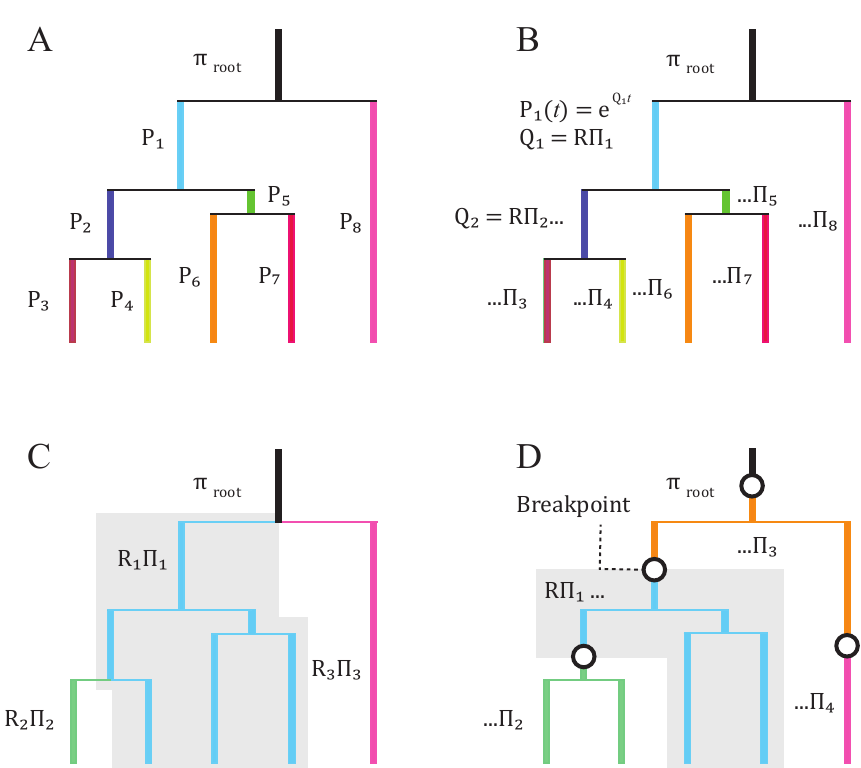
Figure 1. Illustration of the variety of nonstationary and non-time-homogeneous phylogenetic models. ( A ) The Barry-Hartigan model is the most general possible Markov substitution model. The substitution process is modeled by an arbitrary Markov transition matrix for each branch (P 1 –P 8 , indicated by branch colors) and a vector of initial frequencies at the root π root . ( B ) A homogeneous but nonstationary model. Transition matrices are derived from a reversible continuous-time Markov model. All branches share the same rate matrix R, but the stationary frequencies Π i are permitted to vary across the tree. ( C ) A non-homogeneous model reflecting more recent methods whereby a small number of reversible Markov models with different rates and frequencies are assigned to multiple branches within the tree (shaded region). ( D ) A nonstationary ‘breakpoint’ model in which state frequencies may differ within as well as among